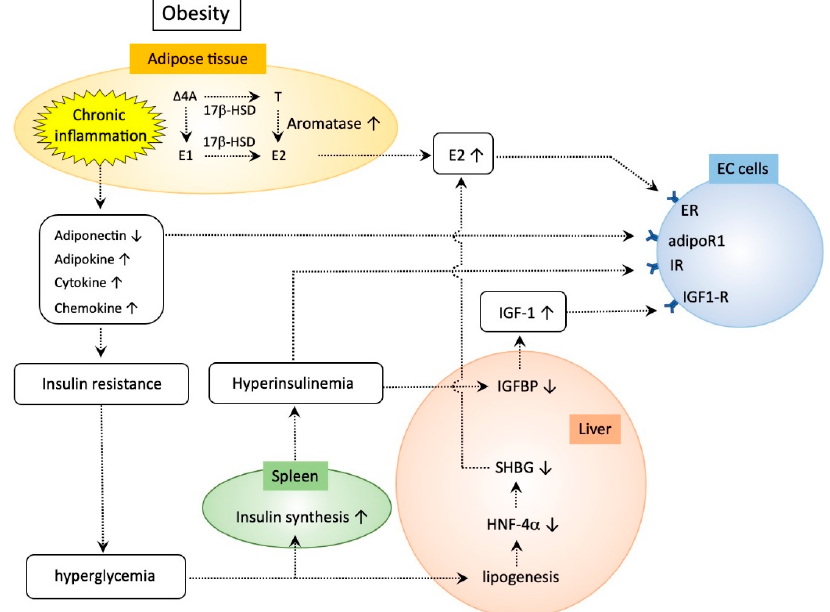
Figure 1. Potential mechanisms of obesity-induced development of endometrial cancer (EC). Obesity